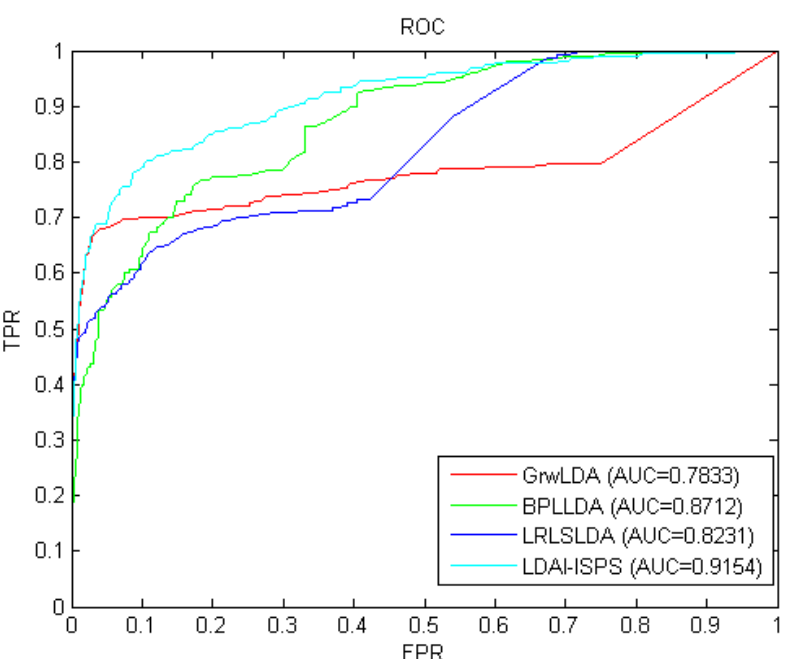
Figure 2. The receiver operating characteristic (ROC) curves and AUC values of the long non-coding RNA (lncRNA)–disease associations inference based on integrated space projection scores (LDAI-ISPS) compared with other methods.